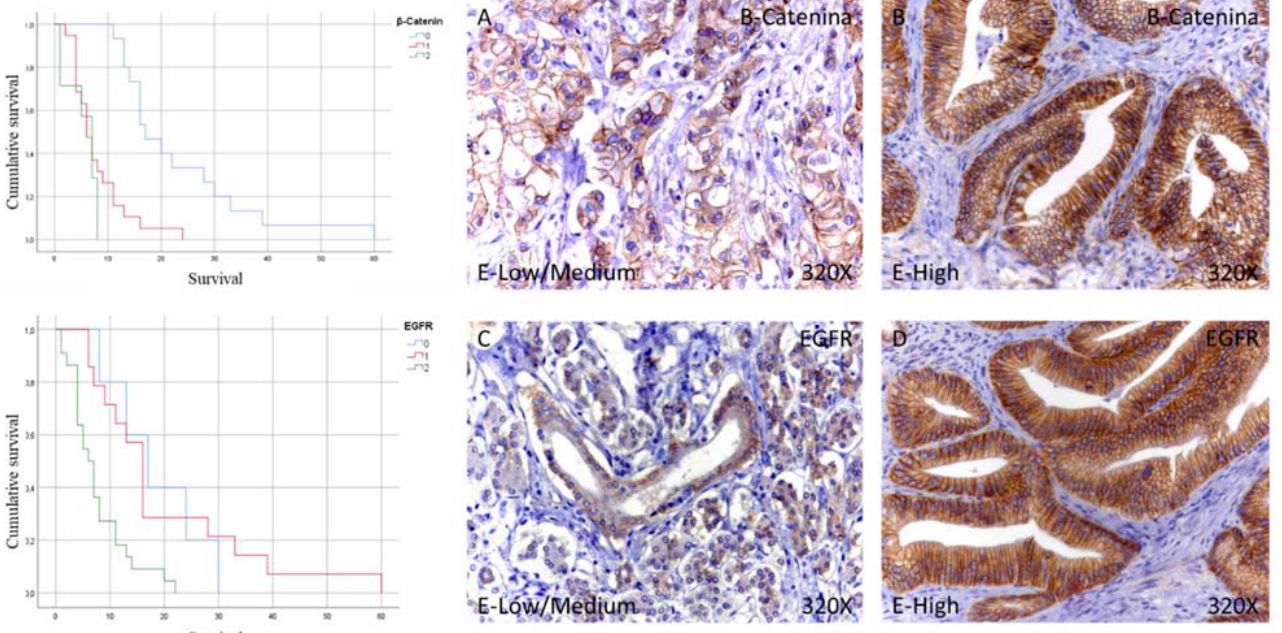
Figure 2. Kaplan–Meier curves for survival time according to tumor expression ( left ) and images showing the protein expression of beta catenin and EGFR in patients diagnosed with pancreatic cancer ( right A – D ). E-Low/Medium = tissue expression classified as low/medium; E-High = tissue expression classified as high; 320 × magnification. Histological samples from patients diagnosed with pancreatic cancer were classified as negative expression (0), low/medium (1), and high (3) using the IRS Score method n = 41.